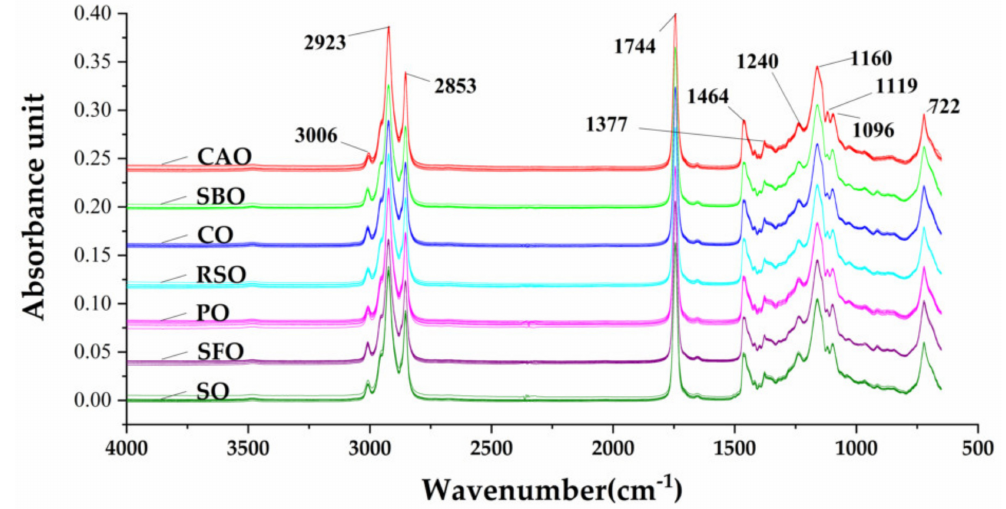
Figure 1. FTIR spectra of CAO, SBO, CO, RSO, PO, SFO, and SO in the full region of 4000–650 cm − 1 . CAO, camellia oil; SBO, soybean oil; RSO, rapeseed oil; CO, corn oil; SFO, sunflower oil; PO, peanut oil; SO, sesame